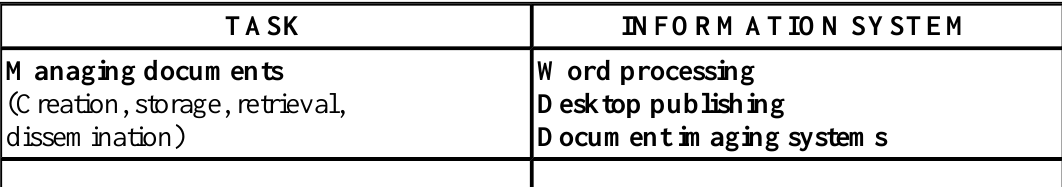
Table 1. Factors that influence the information environment of the office worker